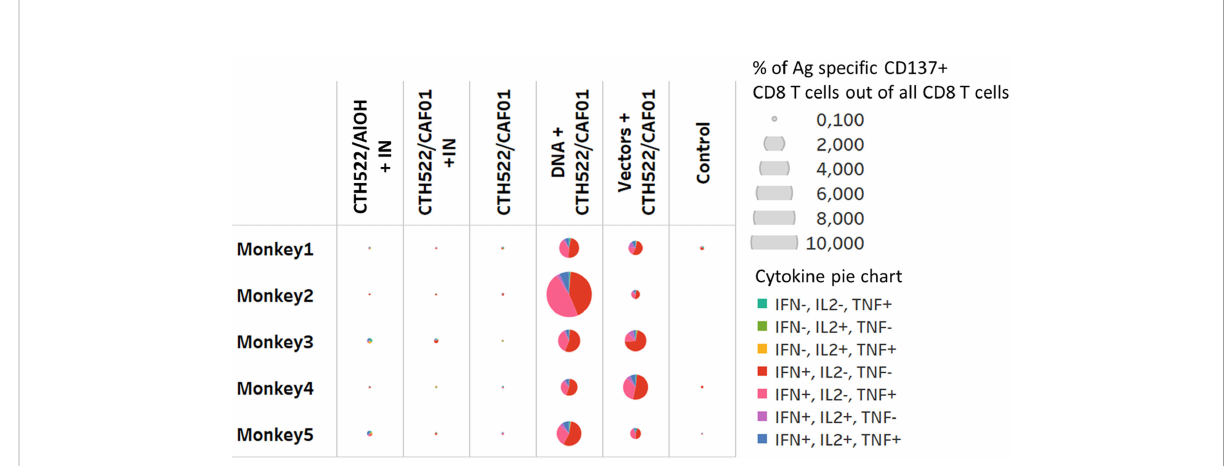
FIGURE 6 CD8 T cells responses. Multifunctional analyses week 22. Cytokine production by CD8 + T cells assayed by ICS. Multifunctional responses after stimulation with pools of overlapping peptides from MOMP are represented. The size of each pie is proportional to the percentage of CD137 + CD8 + T cells expressing at least one cytokine, including IFN- g , TNF- a , and IL-2, and the proportions of cells expressing IFN- g and/or TNF- a and/or IL-2 cytokines are displayed in each pie.